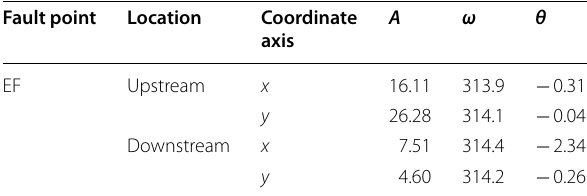
Table 7 Sine Parameters in the case of fault at EF Fault point